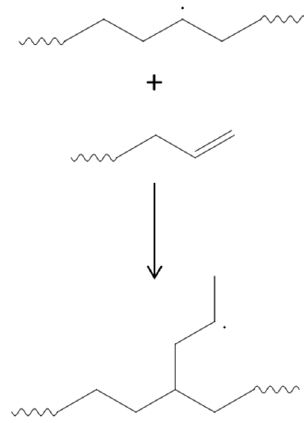
Figure 7. Mechanism of cross-linking of ultra-high-molecular-weight polyethylene (UHMWPE) through consumption of vinyl double bonds.